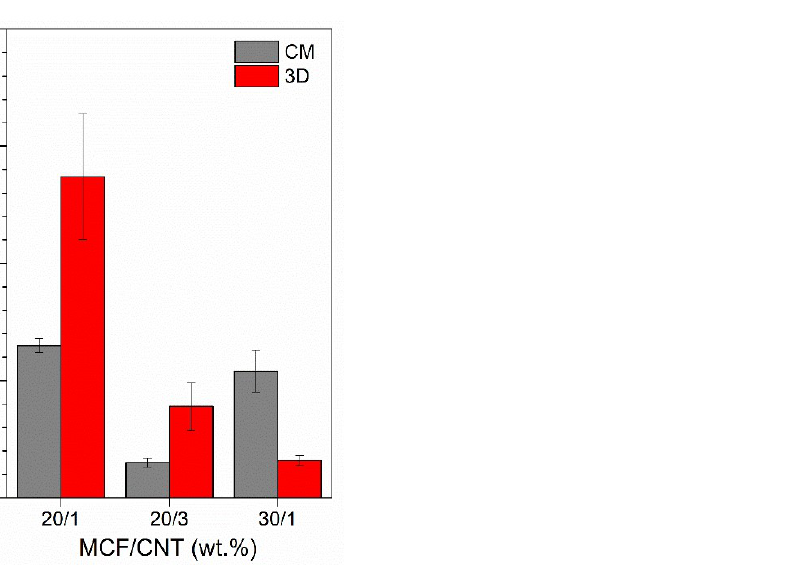
Figure 14. Electrical resistivity of CM and 3D-printed samples in different MCF and CNT contents.